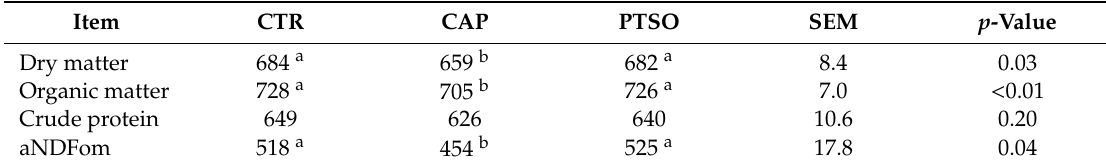
Table 5. E ff ect of propyl-propane thiosulfonate and capsicum oleoresin addition on the apparent total tract digestibility (g / kg) of dairy cows (n = 6) 1